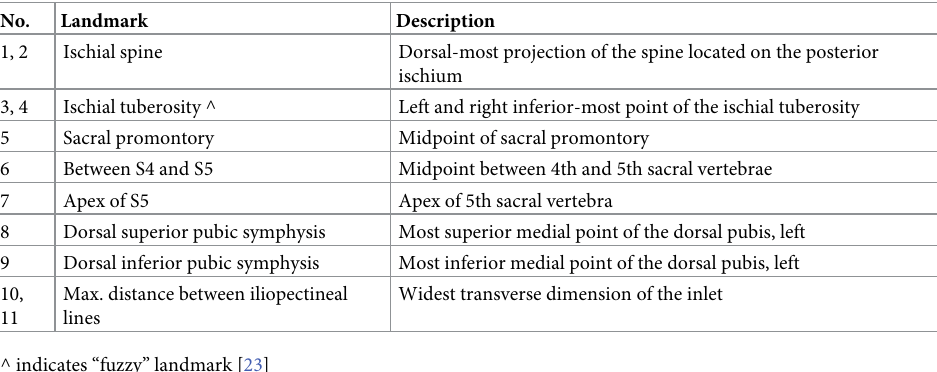
Table 2. Landmark